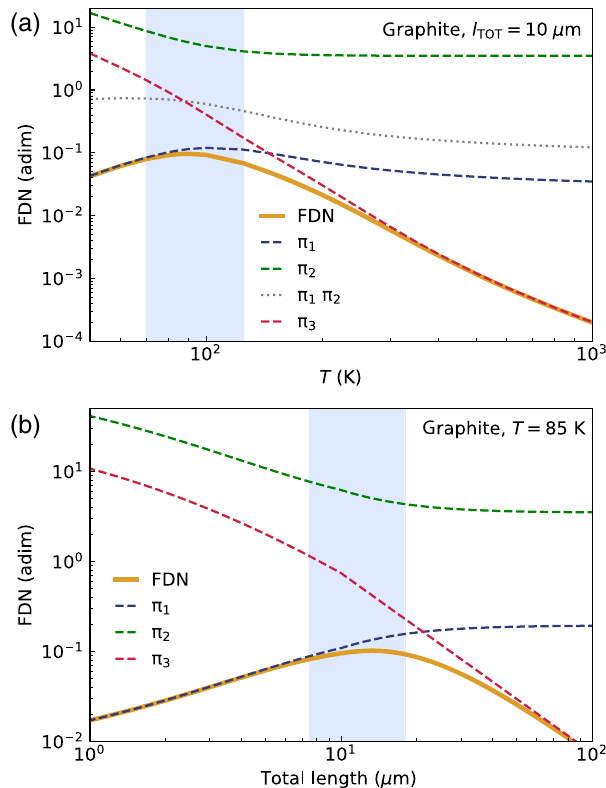
FIG. 6. Fourier deviation number (solid line) and its different contributions π 1 and π 3 [Eq. (22)] for a graphite sample of fixed 10 μ m as a function of temperature (a), and at fixed length l TOT ¼ ¯ T ¼ 85 K as a function of sample ’ s length l TOT (b). The shaded areas are the hydrodynamic (second-sound) windows measured at 10 μ m (a) or 85 K (b) by Huberman et al. [43]. The terms π 2 and π 1 π 2 are also reported in (a) because in the high-temperature limit Fourier ’ s law is recovered when π 1 π 2 ≪ 1 (see main text for details). Notably, the FDN predicts hydrodynamic effects to be largest at temperatures and sizes that are in excellent agreement with these observed in the